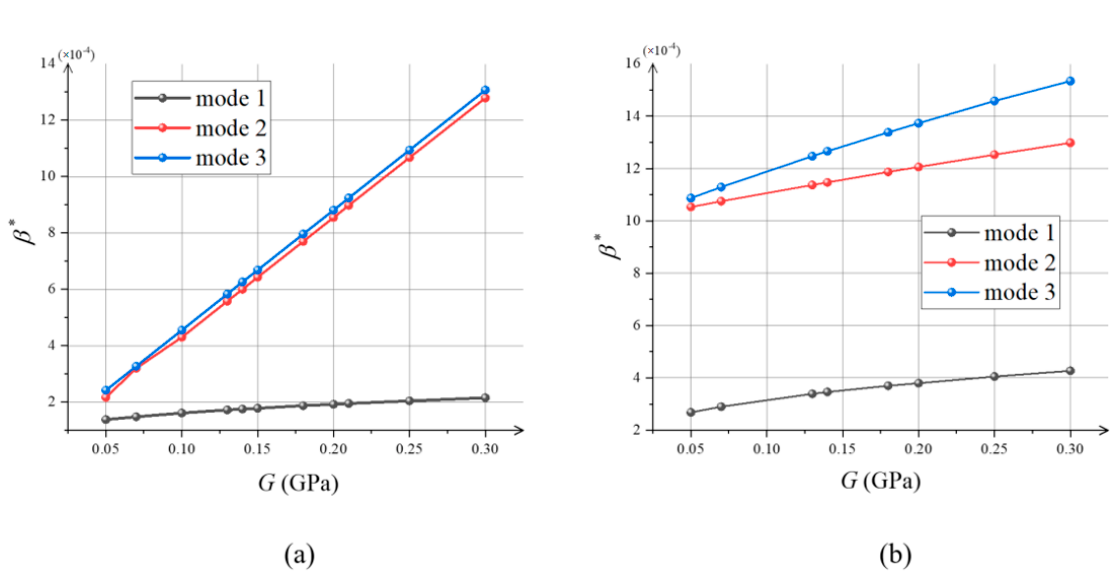
Figure 5. The variation in the critical intrinsic strain β * of orthotropic materials with the principal shear modulus G : ( a ) when n = 2; ( b ) when n = 10.